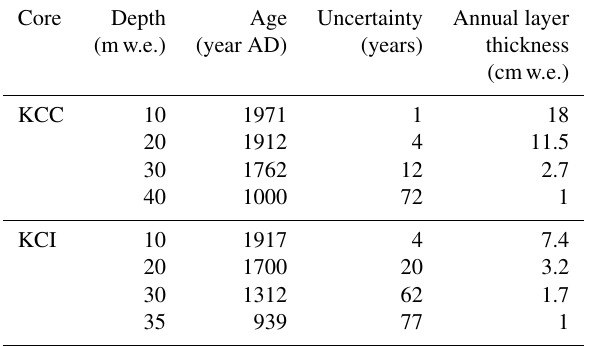
Table 3. Ice core age, dating uncertainty and annual layer thickness for selected